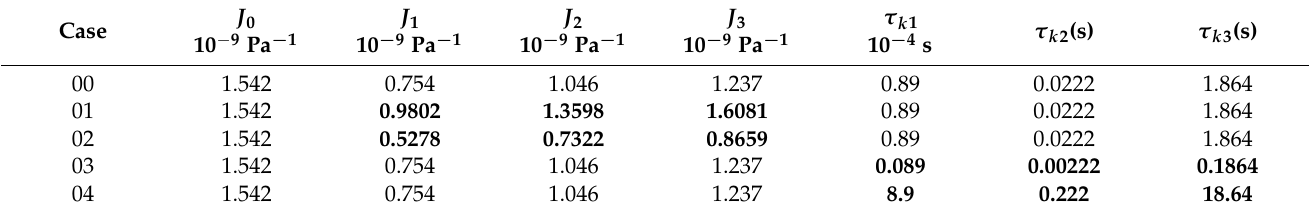
Table 3. Tested creep function details.